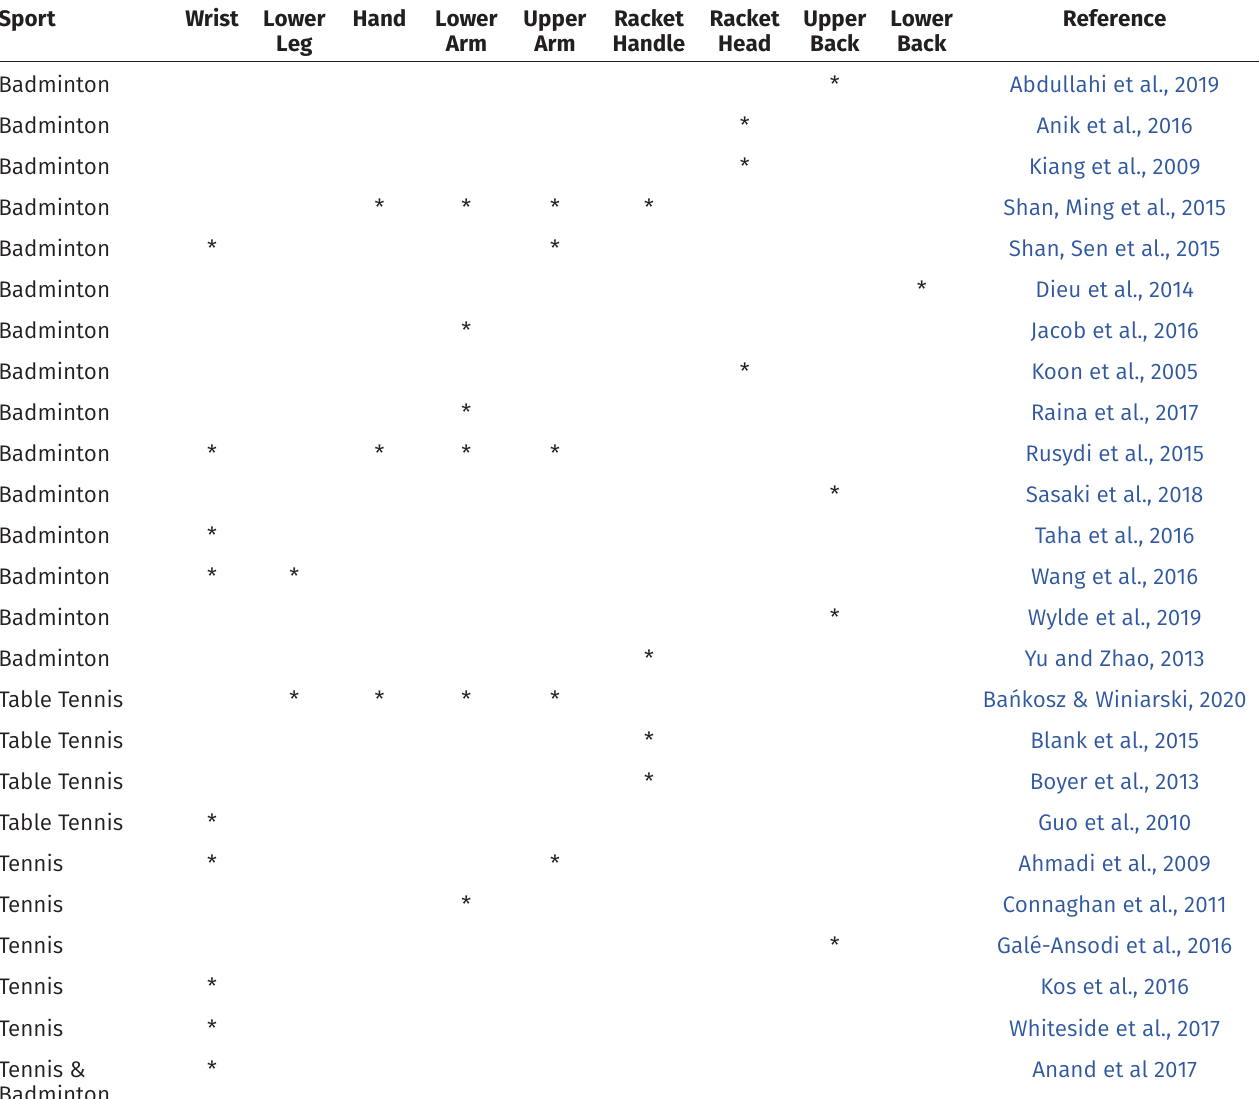
Table 1. Placement of IMU in Racket